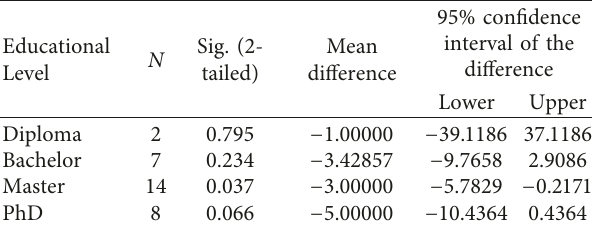
Table 10: Statistic and one-sample t -test for reduced personal accomplishment with reference to educational